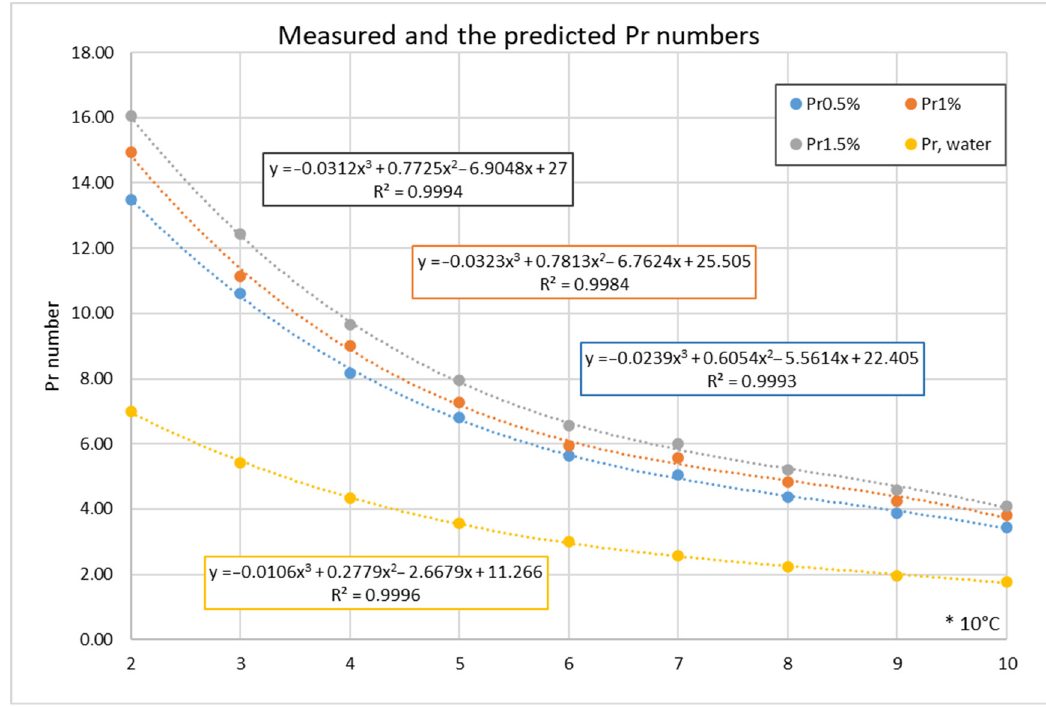
Figure 2. The measured and the predicted values of the Pr numbers for different concentrations.